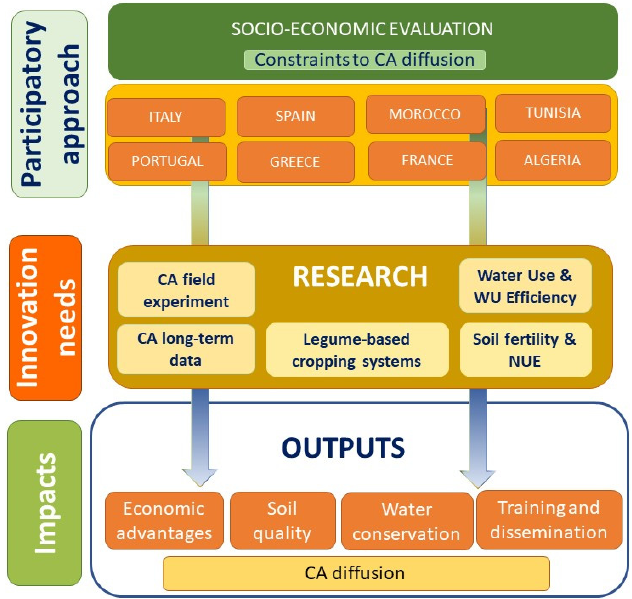
Figure 2. Overall approach adopted within the CAMA project.